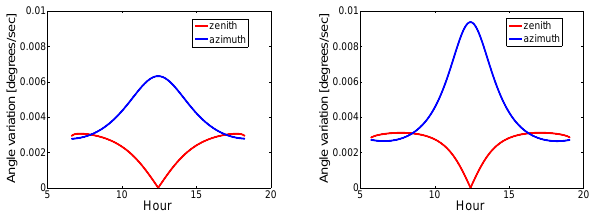
Fig.4. AzimuthandzenithabsoluteSunvariationspersecondinValladolidsiteduringthewinter,ontheleft,andduringthesummer,onthe Fig. 4. Azimuth and zenith absolute Sun variations per second at the right. Valladolid site during the winter on the left, and during the summer on the